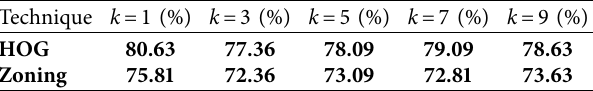
Figure 8: k value vs. accuracy. Table 1: k value vs.